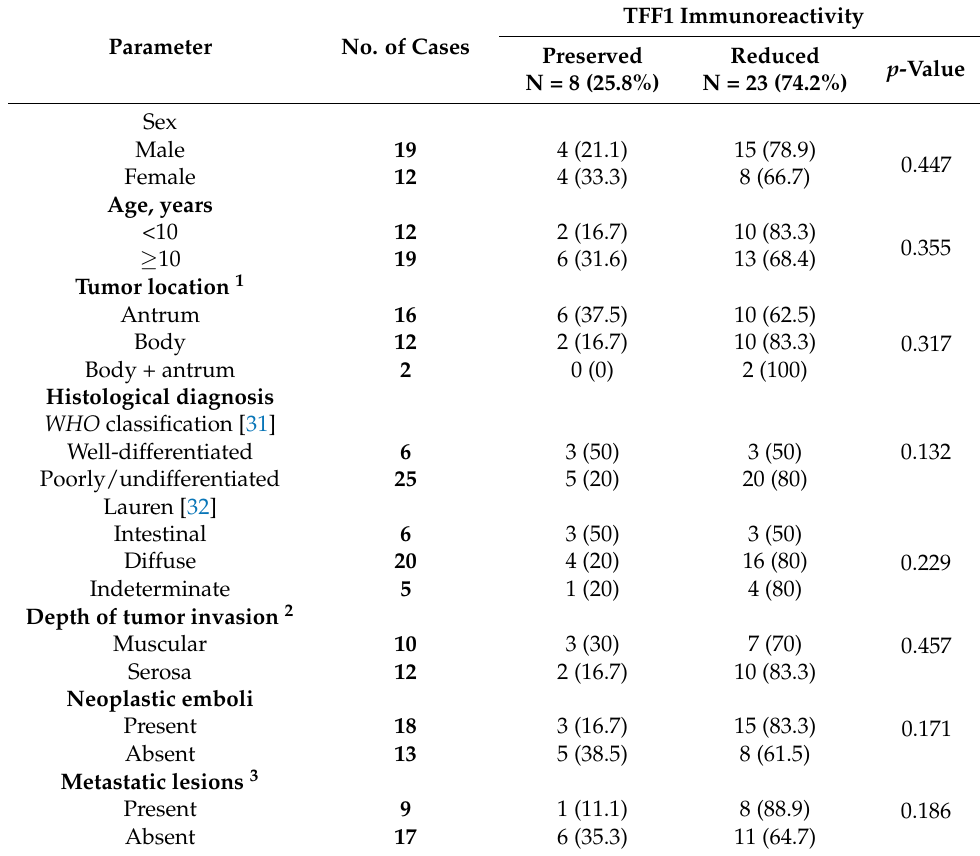
Figure 5. Expression of TFF1 by histological type ( p = 0.0003). Table 2. Association between TFF1 expression and clinicopathological features in 31 canine gastric carcinomas.